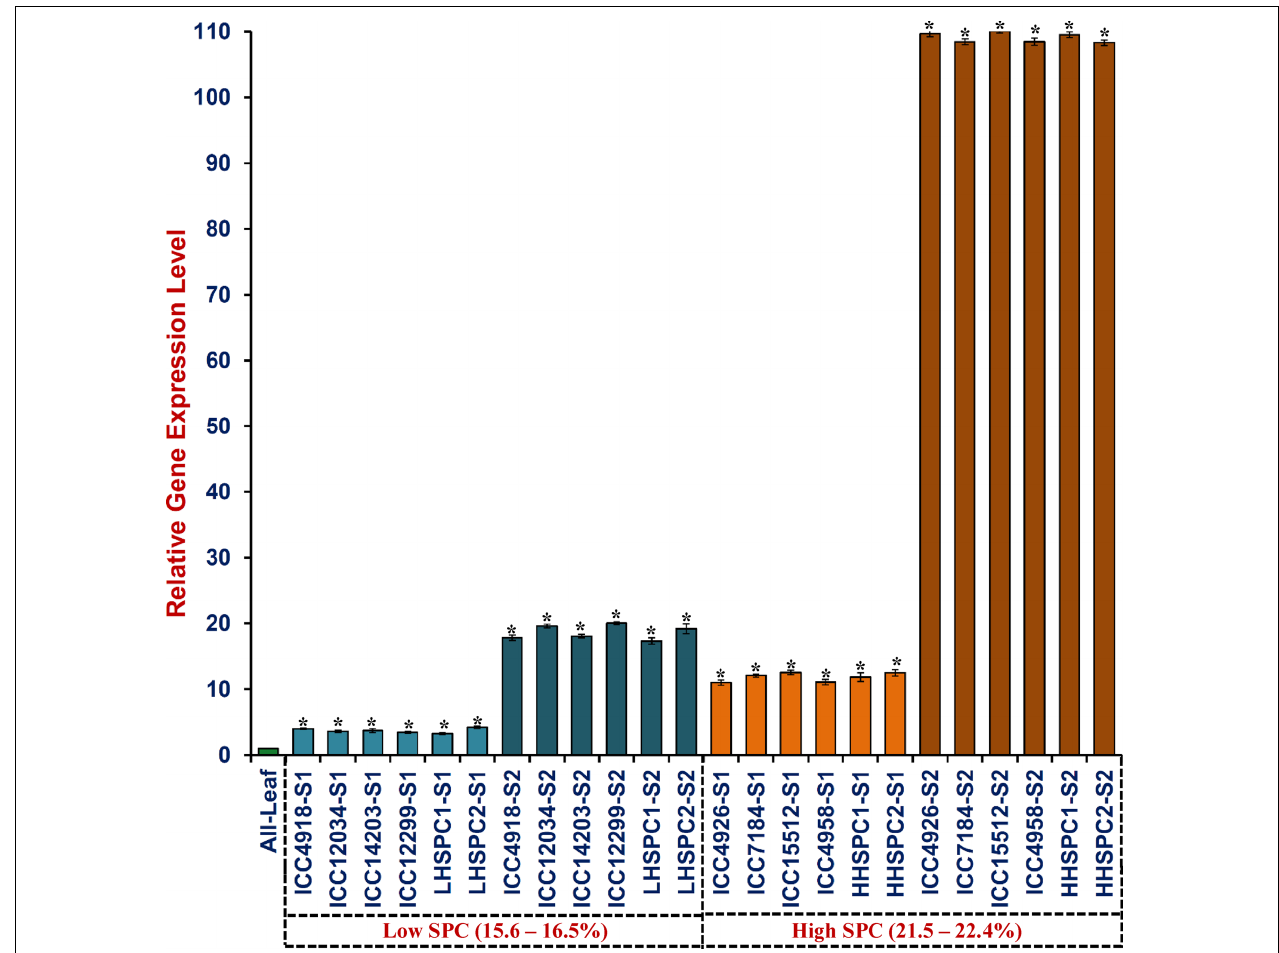
FIGURE 5 | Differential expression profile of a SPC-associated non-synonymous SNP-carrying zinc finger transcription factor gene in the leaves (green colored) as well as early cell division phase and late seed maturation developmental stages of low and high SPC-containing chickpea accessions, parents, and homozygous RIL individuals of an intra-specific mapping population (ICC 12299 × ICC 4958). The endogenous control elongation factor-1 alpha was used to normalize the expression value across different tissues/developmental stages of accessions, parents, and mapping individuals. The gene expression in leaf tissues (indicated as All-Leaf) of all the accessions/parents and mapping individuals was considered as reference calibrator (assigned 1). Each bars denote the mean ( ± SE) of three independent biological replicates with two technical replicates for each sample used in quantitative RT-PCR assay. LHSPC, Low homozygous seed protein containing mapping individual; HHSPC, High homozygous seed protein containing mapping individual; S1, seed development stage 1 (10–20 DAP); and S2, seed development stage 2 (21–30 DAP). The level of gene expression in S1 and S2 developmental stages of low SPC-containing accessions are depicted by light and dark blue-colored bars, respectively. The level of gene expression in S1 and S2 developmental stages of high SPC-containing accessions are illustrated by light and dark brown-colored bars, respectively. ∗ Significant difference in expression of genes at two seed developmental stages of low and high SPC-containing accessions, parents and RIL mapping individuals as compared to leaf at p < 0.01 (LSD-ANOVA significance